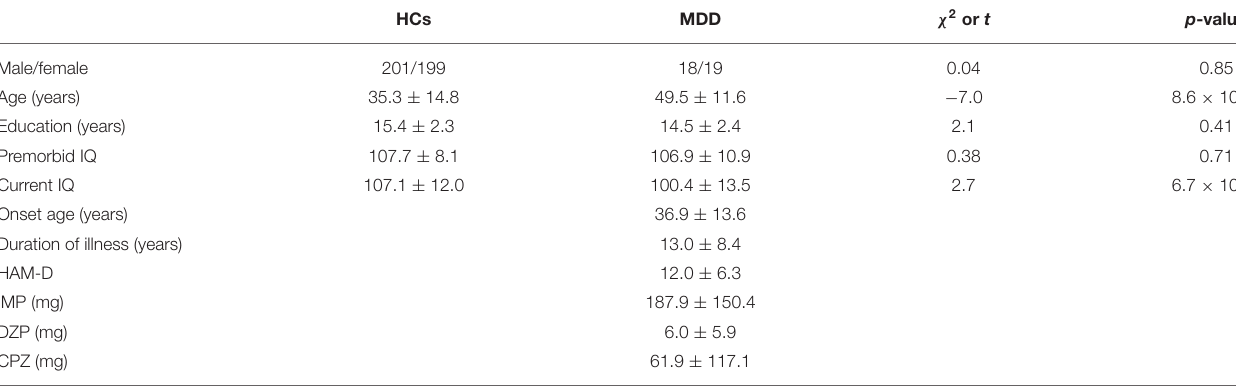
TABLE 2 | Demographics of the HC and MDD groups.